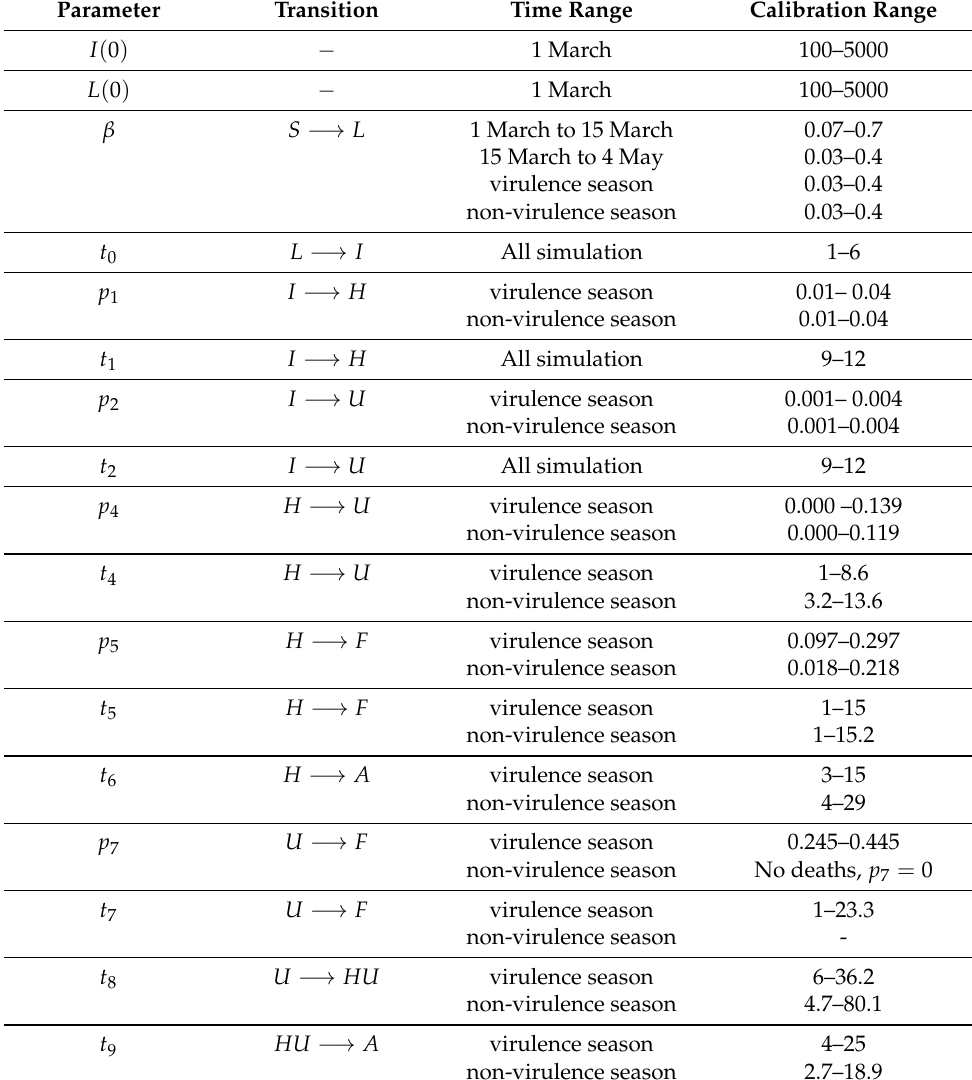
Table 2. Summary of the model parameters to be calibrate and their calibration ranges. The calibration ranges are obtained from the hospital’s